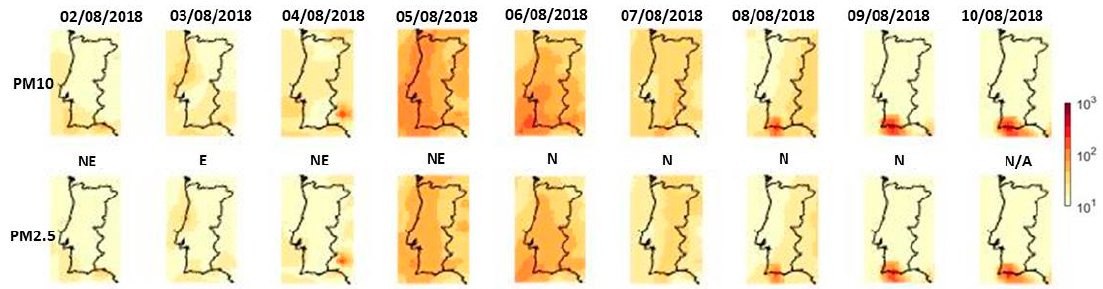
Figure 9. PM10 (upper panel) and PM2.5 (lower panel) maximum concentrations extracted through the near-real time data